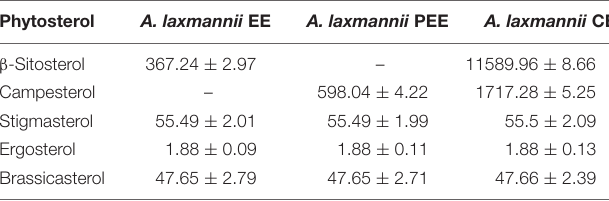
TABLE 4 | The content in sterols in A. laxmannii extracts ( µ g/mL extract).